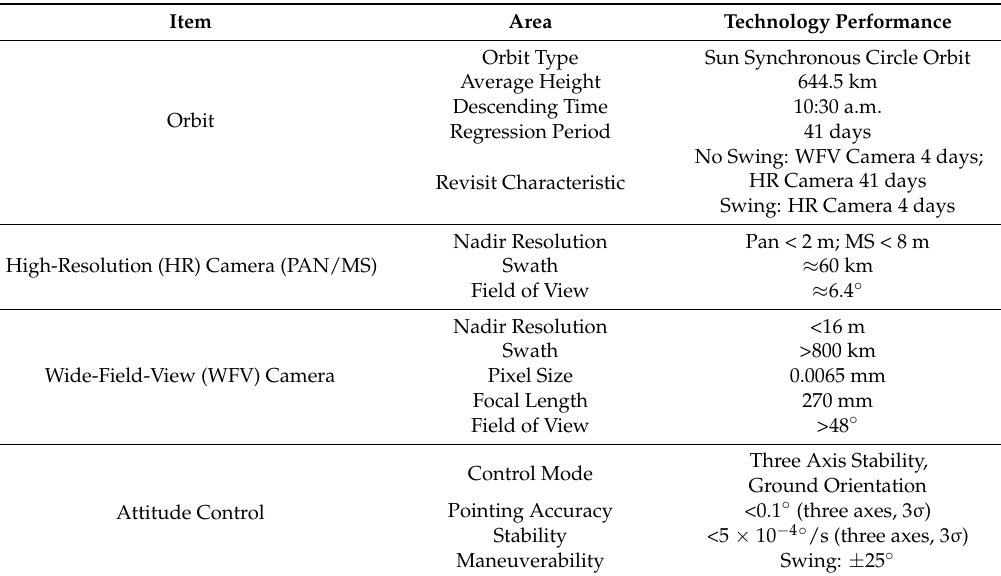
Table 1. Gaofen-1 satellite design parameter